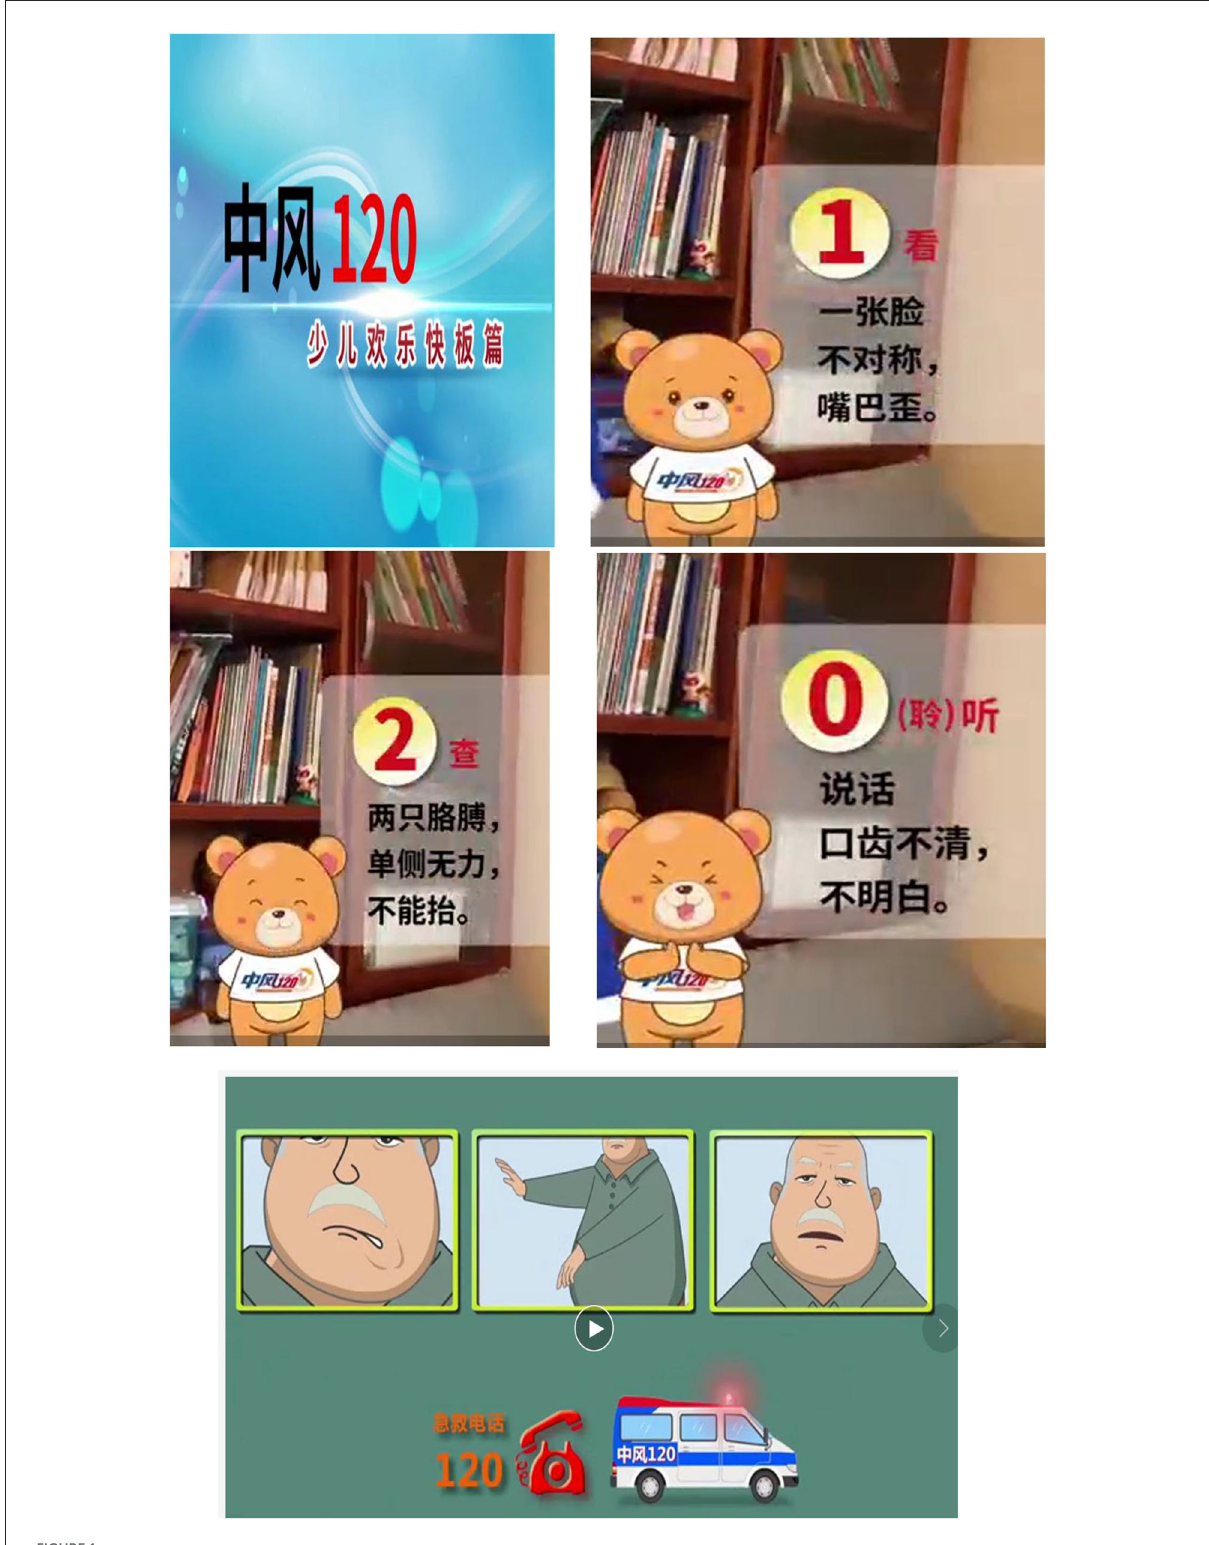
FIGURE1 The educational videos for stroke